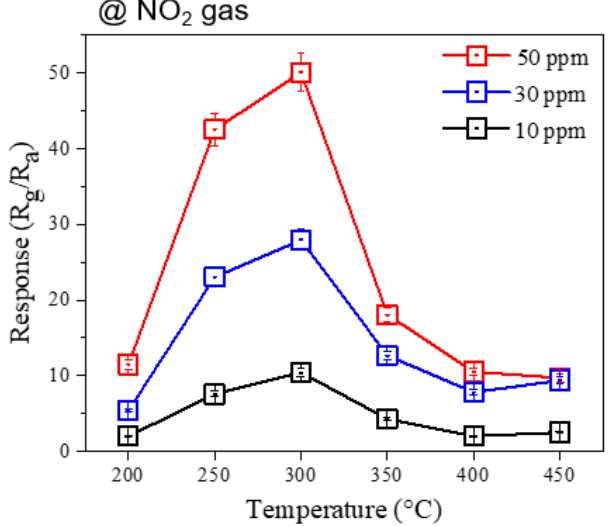
Figure 10. Response vs. sensing temperature of Au-decorated ZnO-PANI (25 wt.%) composite Figure 10 . Response vs. sensing temperature of Au ‐ decorated ZnO ‐ PANI (25 wt.%) composite nan ‐ ofiber gas sensor. nanofiber gas sensor.